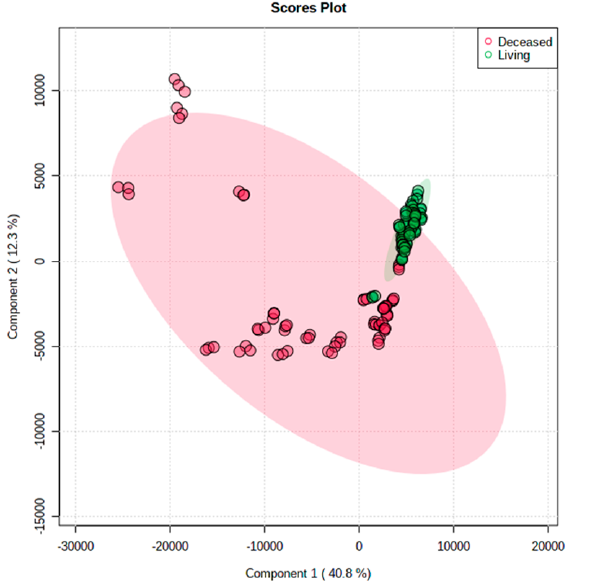
Figure 1. The principal component analysis score plots of deceased and liver donor liver grafts. The plot shows that the metabolites in the living donor liver grafts were similar, but the metabolites varied in the deceased liver grafts.